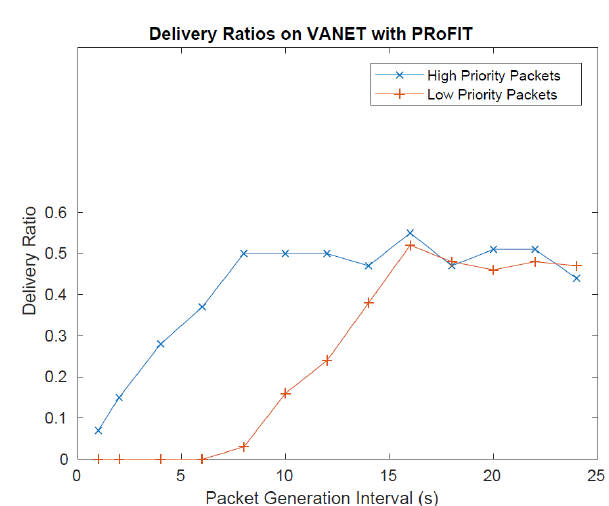
Figure 17. Delivery Ratios on VANET with PRoFIT